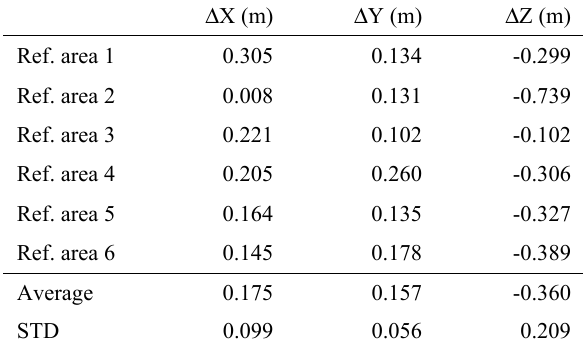
Table 1. The comparison of relatively oriented and transformed